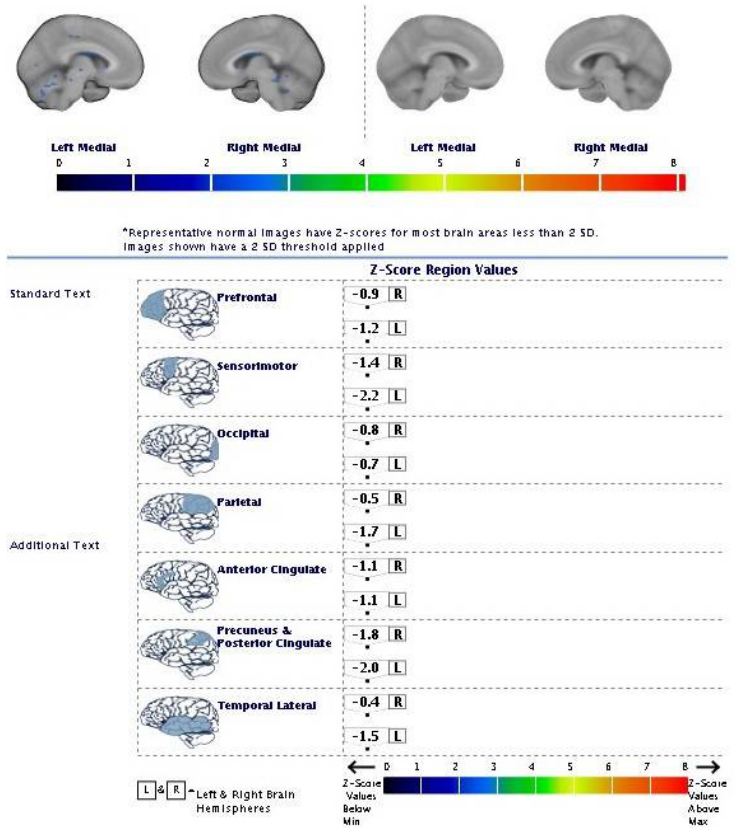
Figure 5. Regional quantification of the 18F-flutemetamol uptake five years after symptom onset: z- score images (cut-off value +2 SD).